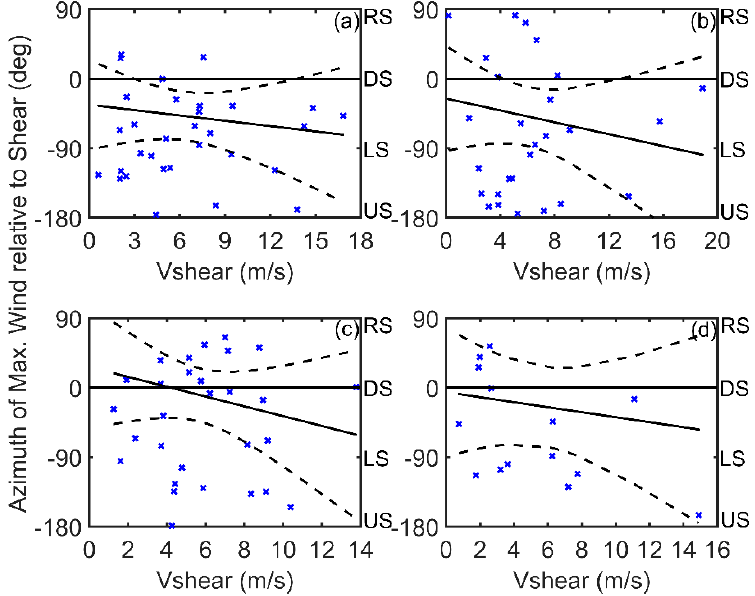
Figure 10. Maximum wind speed position ( θ max ) versus the environmental vertical wind shear magnitude ( V shear ) for ( a ) a tropical storm, ( b ) typhoon, ( c ) severe typhoon, and ( d ) super typhoon, as shown in Figure 3. The black solid and dashed lines represent linear regressions and 95% confidence intervals for the fits, respectively. θ max ( ◦ ) is clockwise azimuth relative to the wind shear direction. RS indicates that θ max is located on the right side of the wind shear, LS indicates that θ max is located on the left side of the wind shear, DS indicates that θ max is ‘ downshear ’, and US indicates that θ max is ‘ upshear